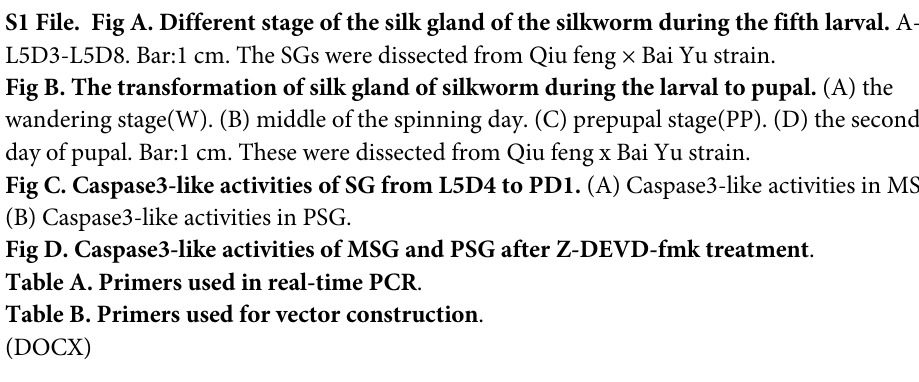
Fig C. Caspase3-like activities of SG from L5D4 to PD1. (A) Caspase3-like activities in MSG. (B) Caspase3-like activities in PSG. Fig D. Caspase3-like activities of MSG and PSG after Z-DEVD-fmk treatment . Table A. Primers used in real-time PCR . Table B. Primers used for vector construction